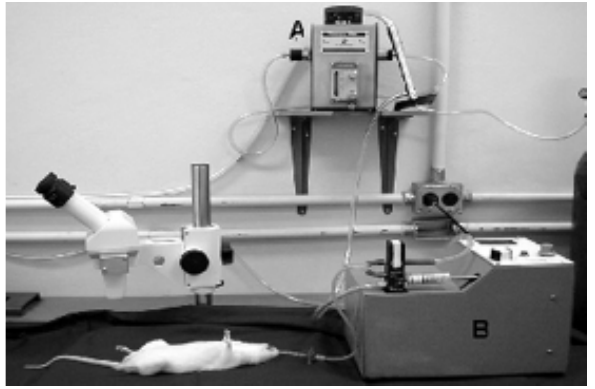
Fig. 1 – Fotografia demonstrando o rato intubado, anestesiado e sob ventilação mecânica, pronto para instilação da solução de papaína. A – Nebulizador de gases. B- ventilador para pequenos animais.